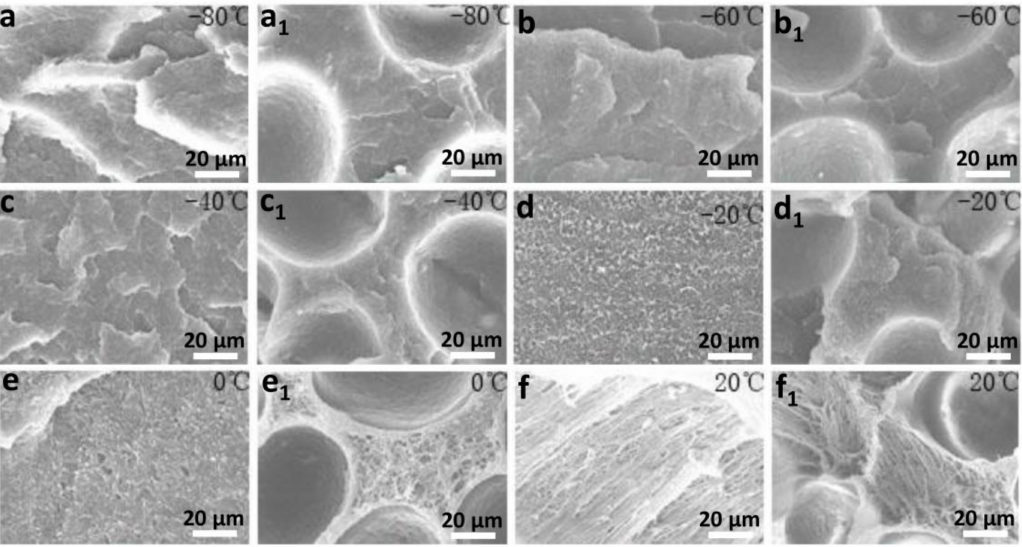
Figure 9. Microstructure of the foamed and unfoamed PP/POE composites at different temperatures: ( a – f ) unfoamed sample, ( a 1 – f 1 ) foamed